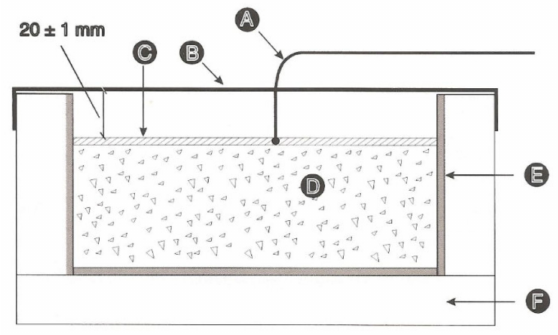
Figure 6. Freeze / thaw test set-up. A: Thermo element; B: Protection against evaporation; C: Freezing medium; D: Test specimen; E: Rubber cloth; F: Thermal insulation. [9].